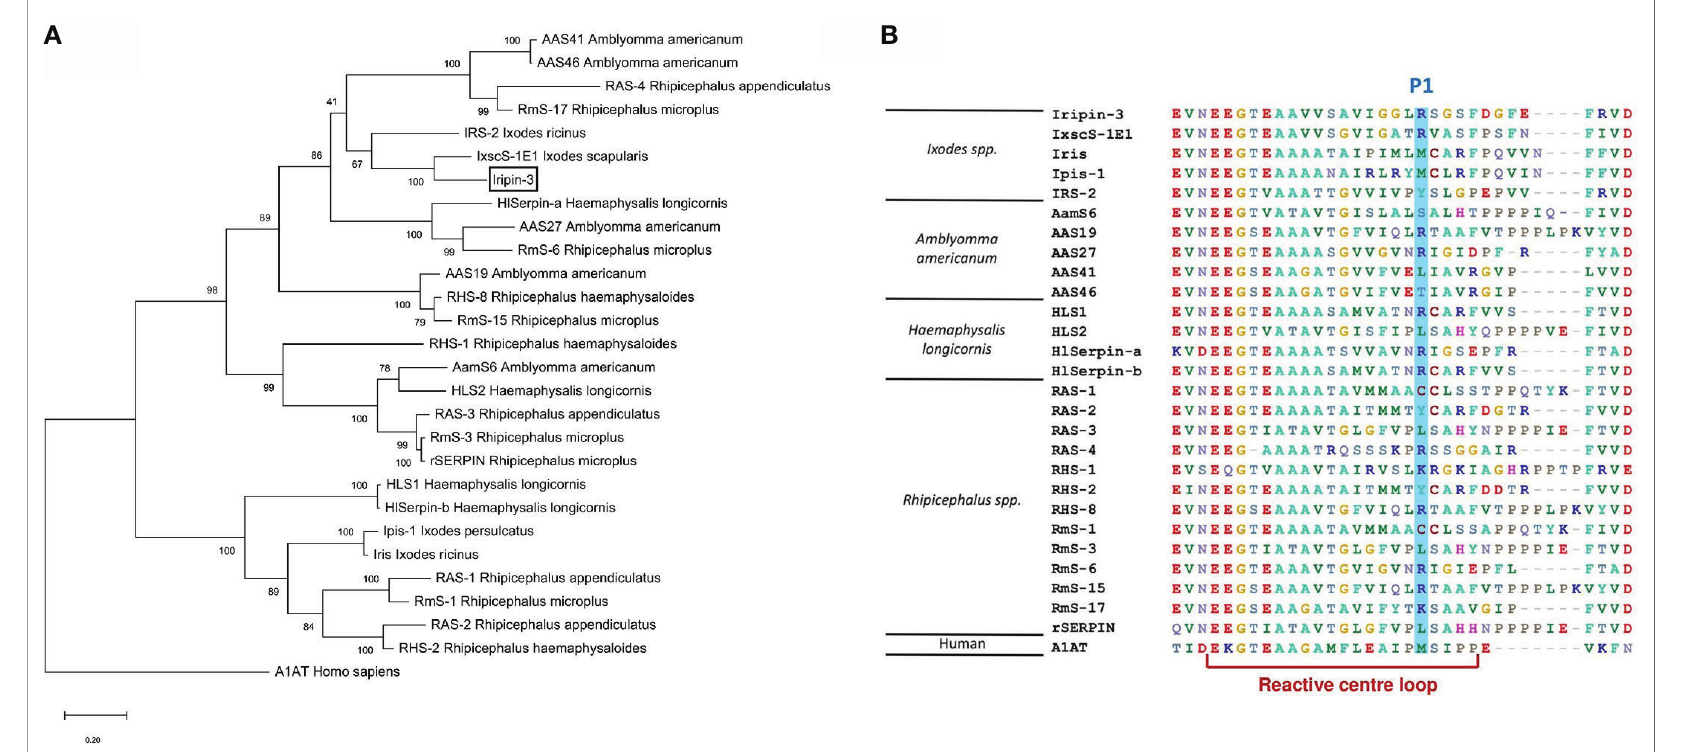
FIGURE 3 | Phylogenetic analysis of selected tick serpins. Protein sequences of previously characterized tick serpins were aligned and analyzed to determine phylogenetic relationships. (A) A phylogenetic tree was built using the maximum likelihood method and JTT matrix-based model. Alpha-1-antitrypsin (A1AT) was utilized as an outgroup to root the tree. The branch length represents the number of substitutions per site. The reliability of individual branches, assessed by bootstrapping, is expressed as a percentage of trees in which a given topology was present out of 1,000 replications. Iripin-3 is boxed. (B) Alignment of reactive center loop (RCL) regions of 27 tick serpins and one human serpin was performed using BioEdit. RCLs were determined based on the eight-residue pattern p17[E]-p16[E/K/R]-p15[G]-p14[T/S]-p13[X]-p12-9[AGS]- p8-1[X]-p1 ′ -4 ′ [X] typical for inhibitory serpins (68). Amino acid residues at the predicted P1 site are highlighted in